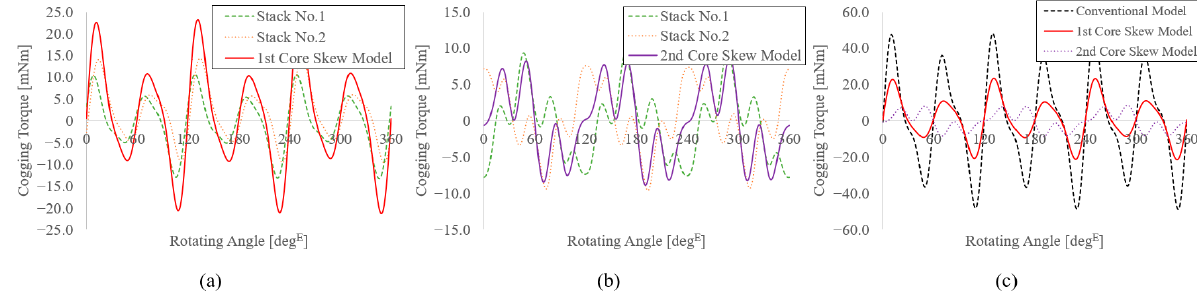
Figure 10. Cogging torque comparison. ( a ) First core skew model cogging torque; ( b ) second core skew model cogging torque; ( c ) comparison between the conventional model and the first and second core skew models.